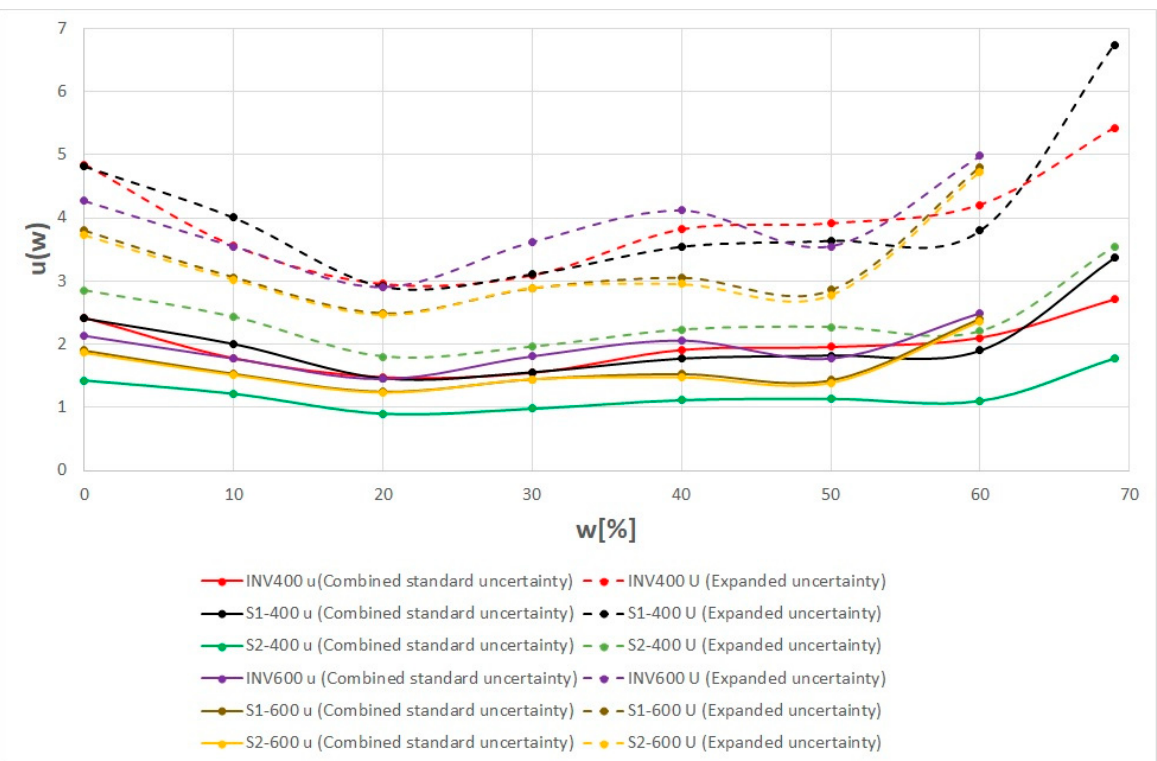
Figure 5. Uncertainty dependence on material moisture: invasive, S1 and S2 sensor, 400 and 600 c.c. samples.